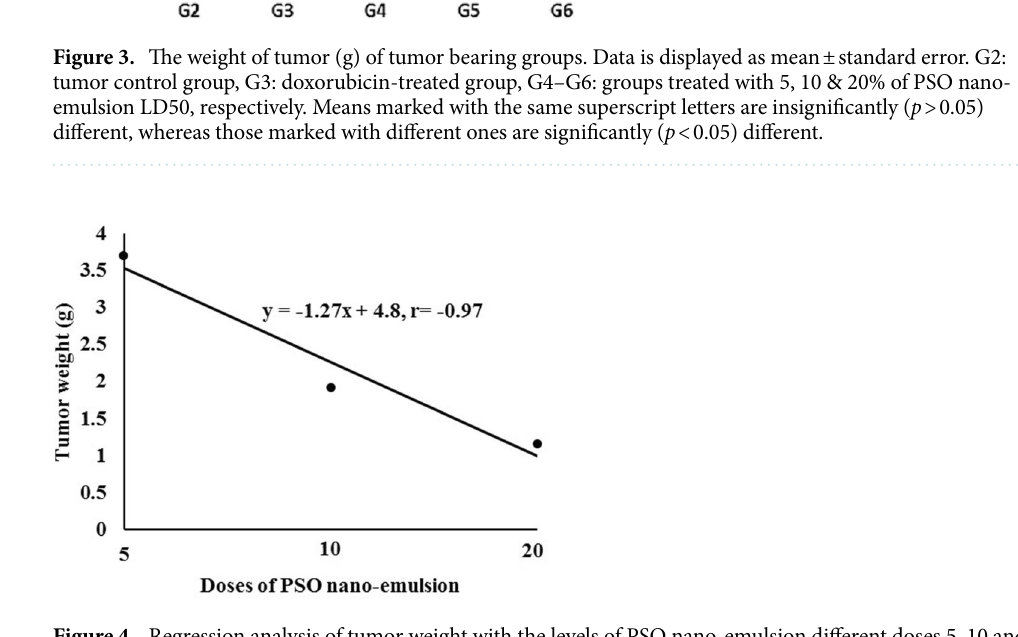
Figure 4. Regression analysis of tumor weight with the levels of PSO nano-emulsion different doses 5, 10 and 20% of PSO nan-emulsion LD50. r: Pearson’s correlation coefficient.